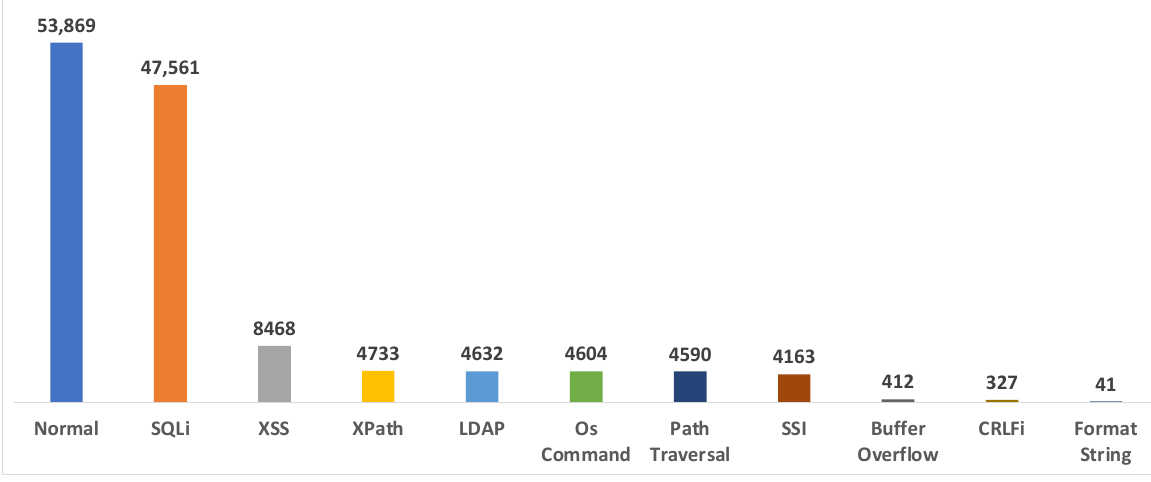
Figure 5. CSIC2012 dataset classes according to attack type.